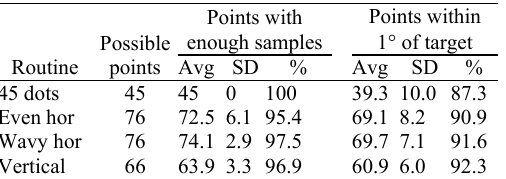
Table 1 Average number of points (across participants) with enough samples and with mapped gaze coordinates within 1 (cid:113) of the tar- get per calibration routine (SD: Standard deviation) Points Points with enough samples Possible Routine points